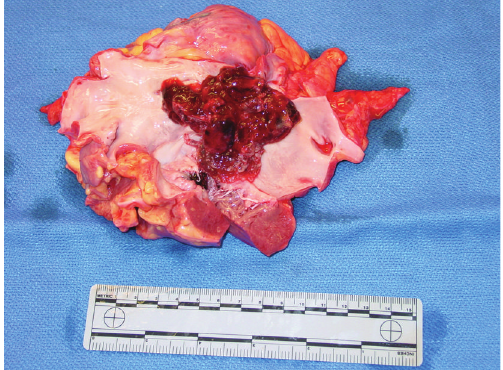
Figure 3: Left atrium opened showing